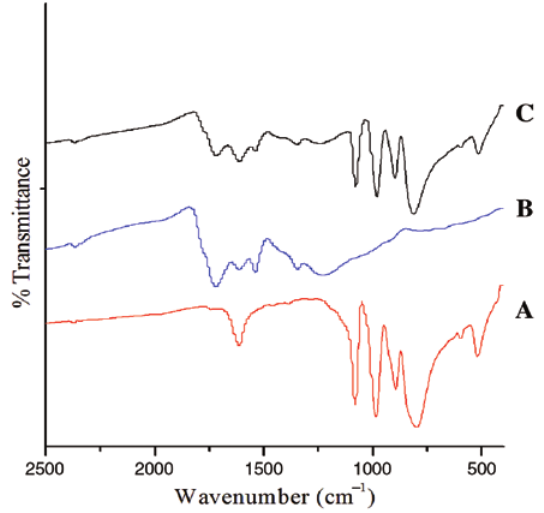
Figure 2: Fourier transform infrared (FTIR) spectrum of the (A) unsupported Co PW O (CoPW), (B) functionalized activated 1.5 12 40 carbon (AC) and (C) AC supported CoPW